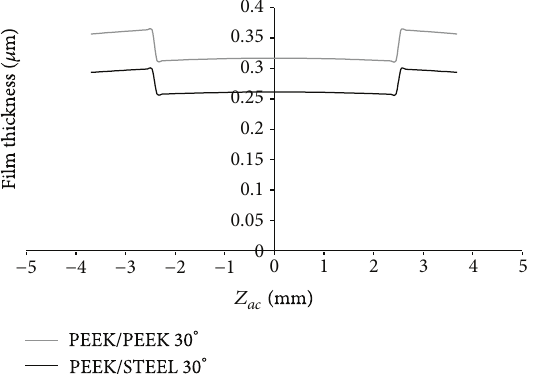
F 5: Variation in minimum �lm thicknesses according to rotational speed across the line of contact.